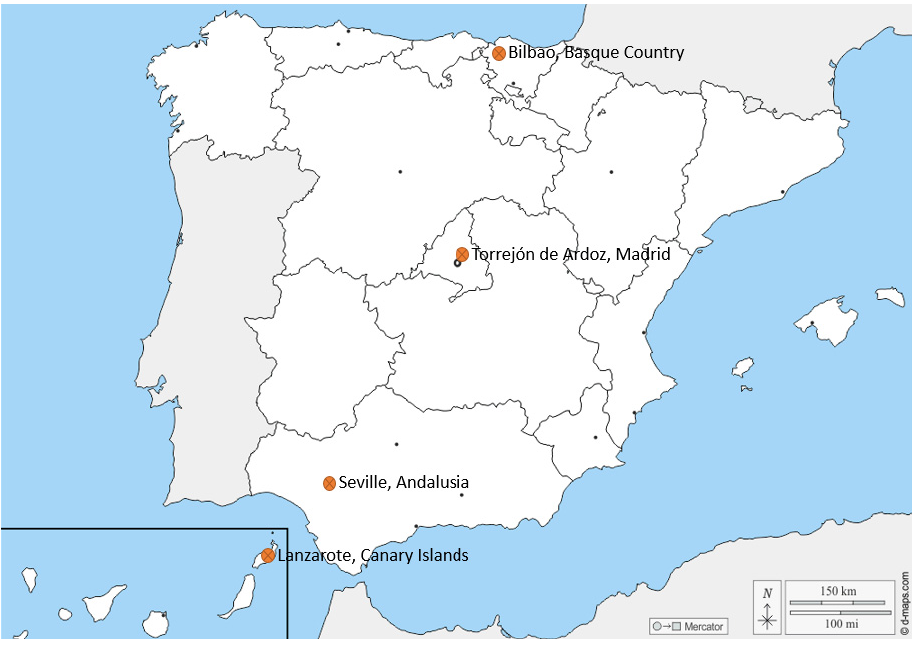
Figure 1. Selected locations, representing different latitudes. Table 1. Locations coordinates used during the simulations.